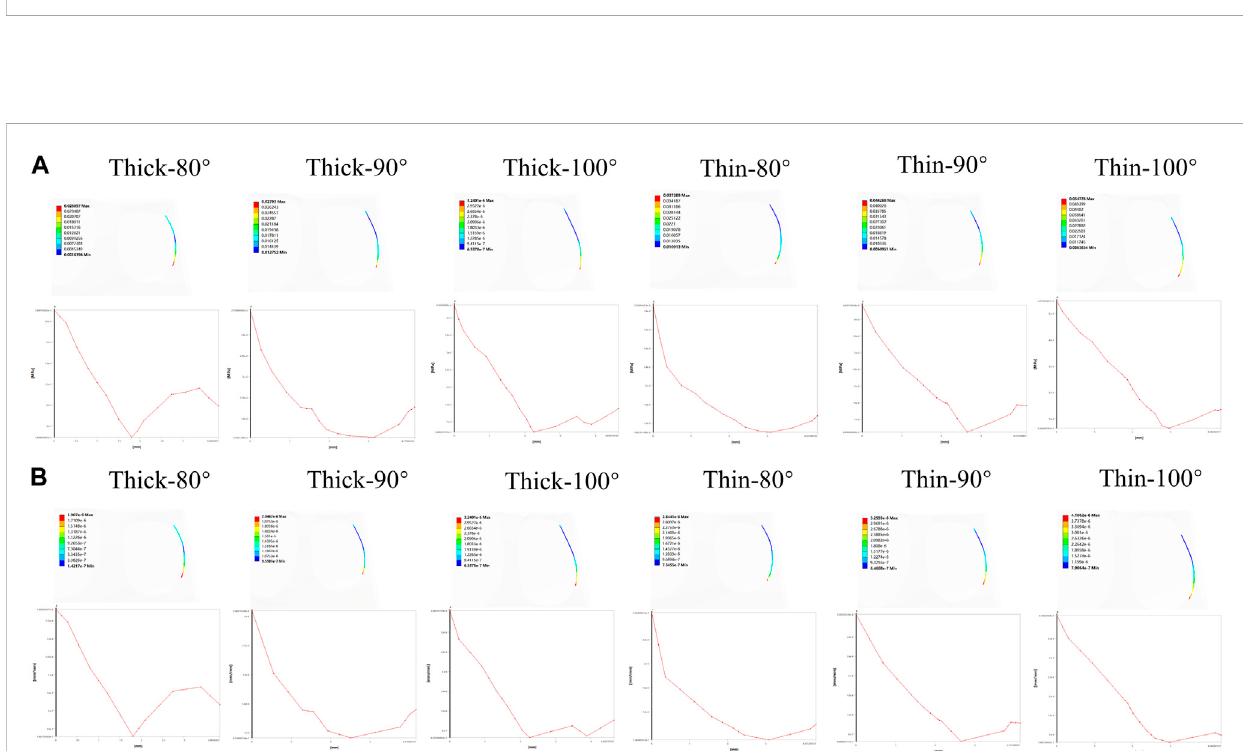
FIGURE 6 The distribution of von Mises stress and strain on a line generated along the proximal alveolar crest in various models (Thick-80 ° ; Thick-90 ° ; Thick- 100 ° ; Thin-80 ° ; Thin-90 ° ; Thin-100 ° ). (A) Von Mises stress on the alveolar bone crest, (B) von Mises strain on the alveolar bone crest.